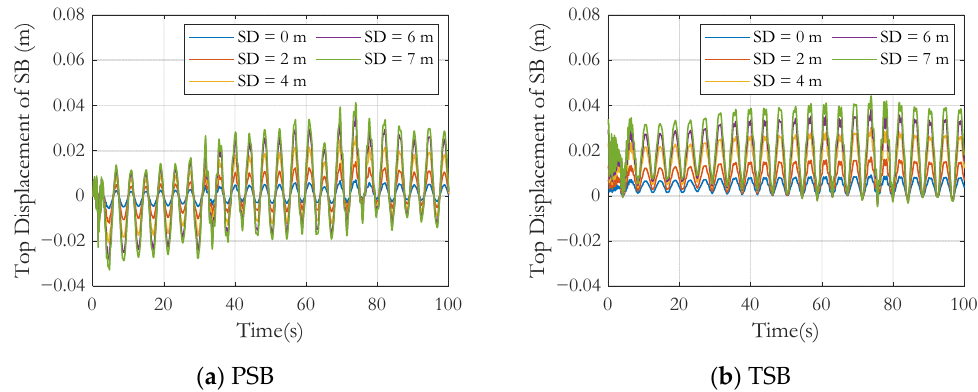
Figure 20. Top displacement of SB under joint action of wind alone and scour condition.